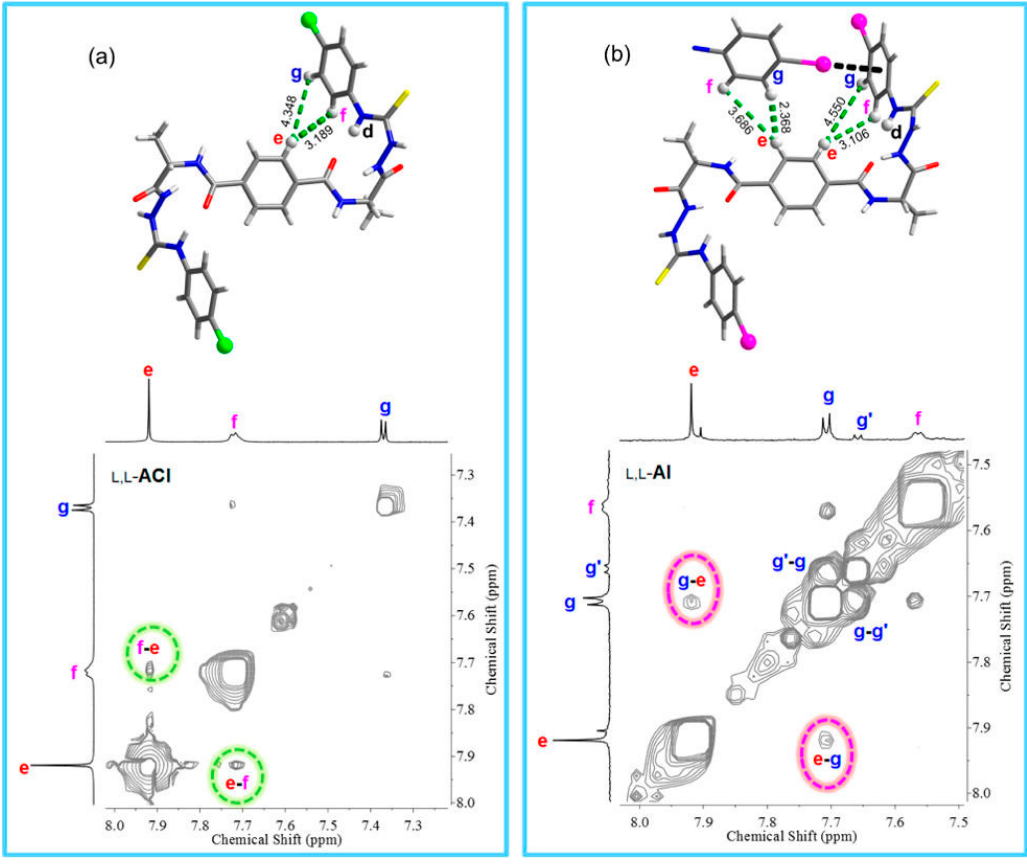
Figure 8. Reproduced from ref. [93]. Sections of 1 H-NOESY spectra showing couplings between protons in phenyl rings in LL-ACl ( a ) and LL-AI ( b ). On top, crystal structures are also shown. Copyright 2017 American Chemical